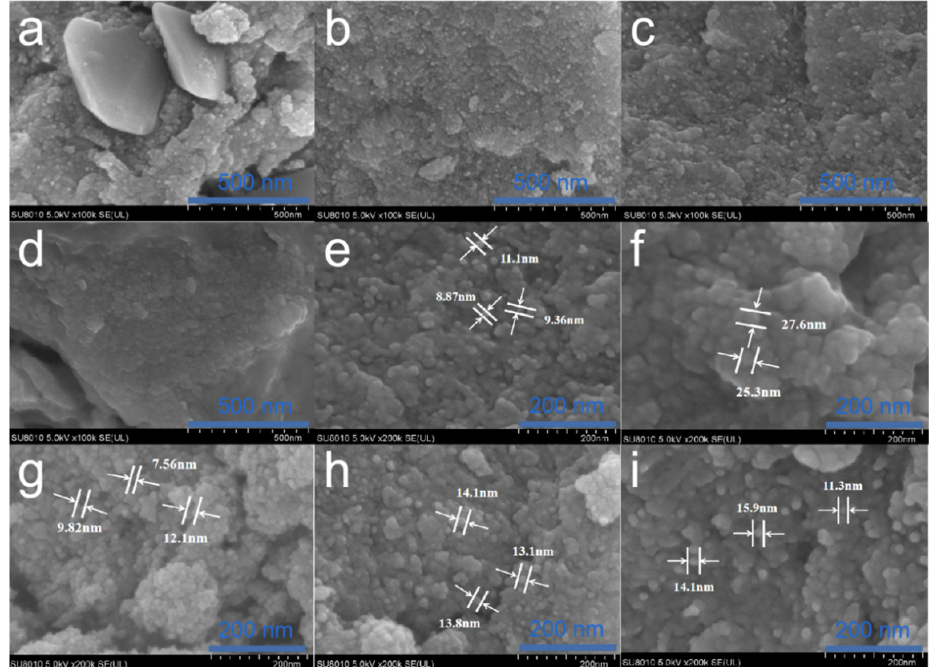
Figure 2. SEM images of adding different surfactants: ( a ) SDS, ( b ) PVP, ( c ) PEG, ( d ) SDBS. SEM images of nano-SnO 2 samples prepared by different F doping ratios: ( e ) n(F)/n(Sn) = 0:1(S0), ( f ) n(F)/n(Sn) = 1:1(S1), ( g ) n(F)/n(Sn) = 1:5(S2), ( h ) n(F)/n(Sn) = 1:10(S3), and ( i ) n(F)/n(Sn) = 1:15(S4).